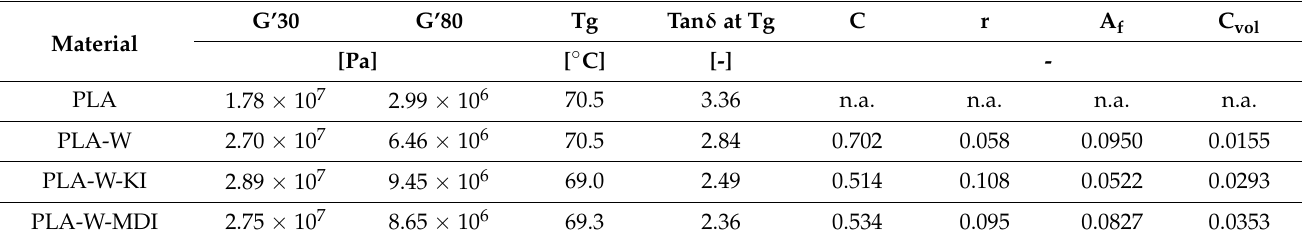
Figure 12. DMTA storage modulus and damping factor vs. temperature plots of PLA and PLA-W composites. Table 2. Thermomechanical parameters obtained from